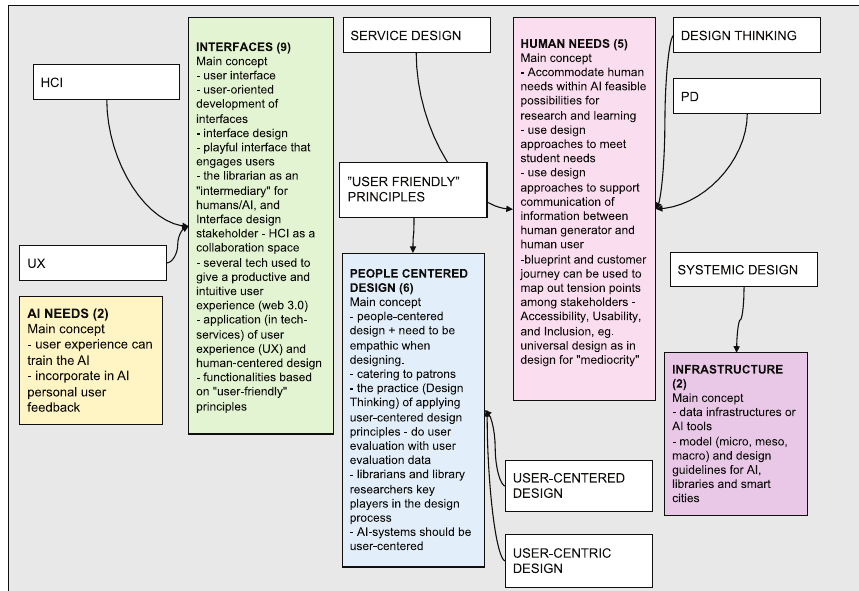
Fig. 2: Affinity diagram of the roles of design